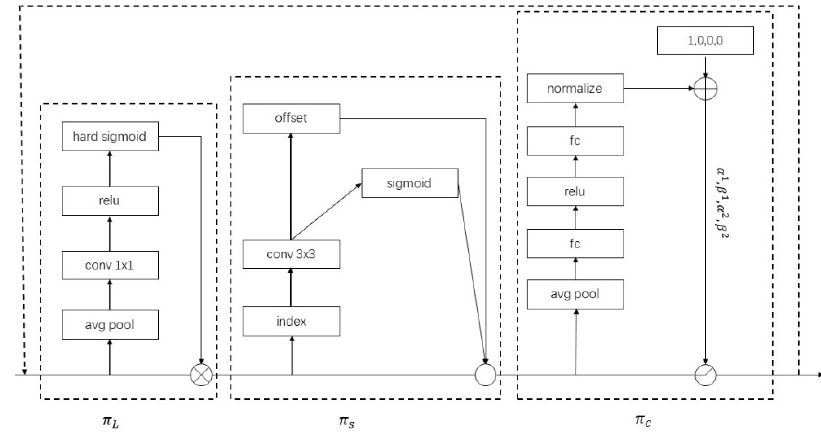
Figure 7. The structure diagram of the Dynamic Head block [23].